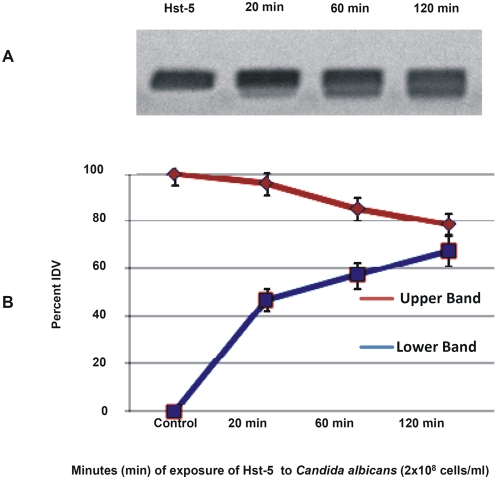
Degradation of Hst-5 by C. albicans over time (minutes) demonstrating degradation level proportional to exposure time.(A) Minor degradation following 20 mins incubation at 37°C observed by the appearance of lower weight product, whereas significantly increasing level of degradation seen following 1 h and 2 h incubation (B) Decrease in the percent of Integrated Density Value (IDV) of the intact Hst-5 (upper band) (P<0.0001) and increase in the IDV of the degradation product (lower band P<0.02) MW: molecular weight ladder.